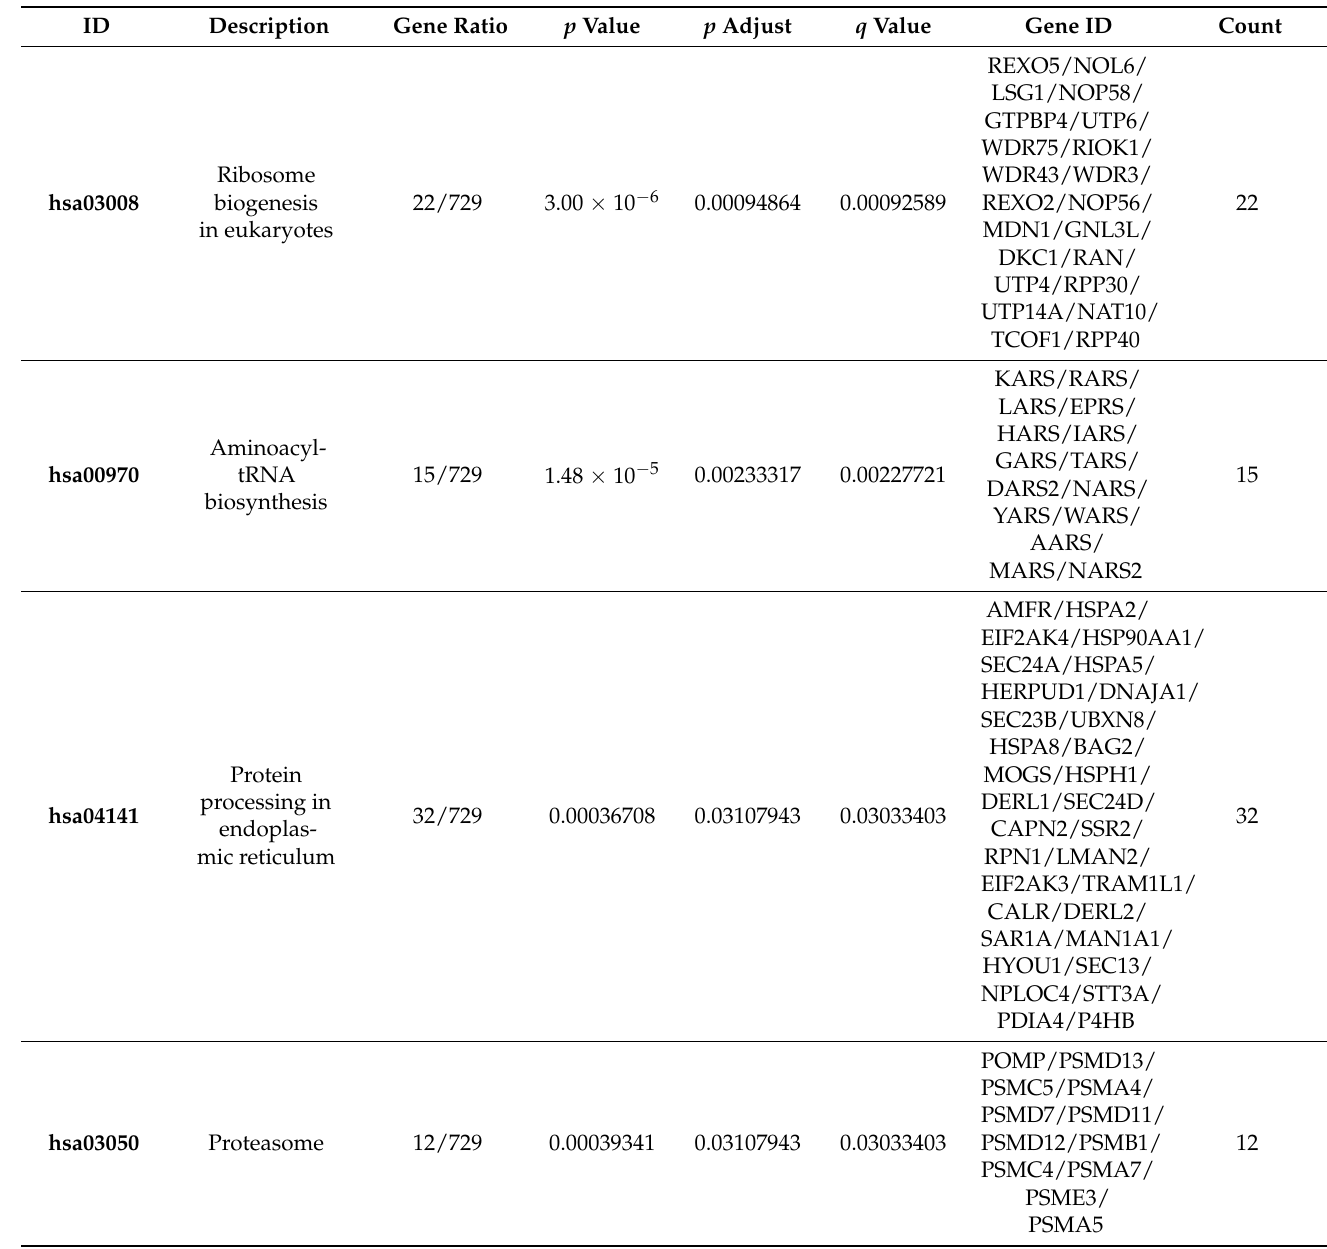
Table 2. Pathways with KEGG enrichment identified in